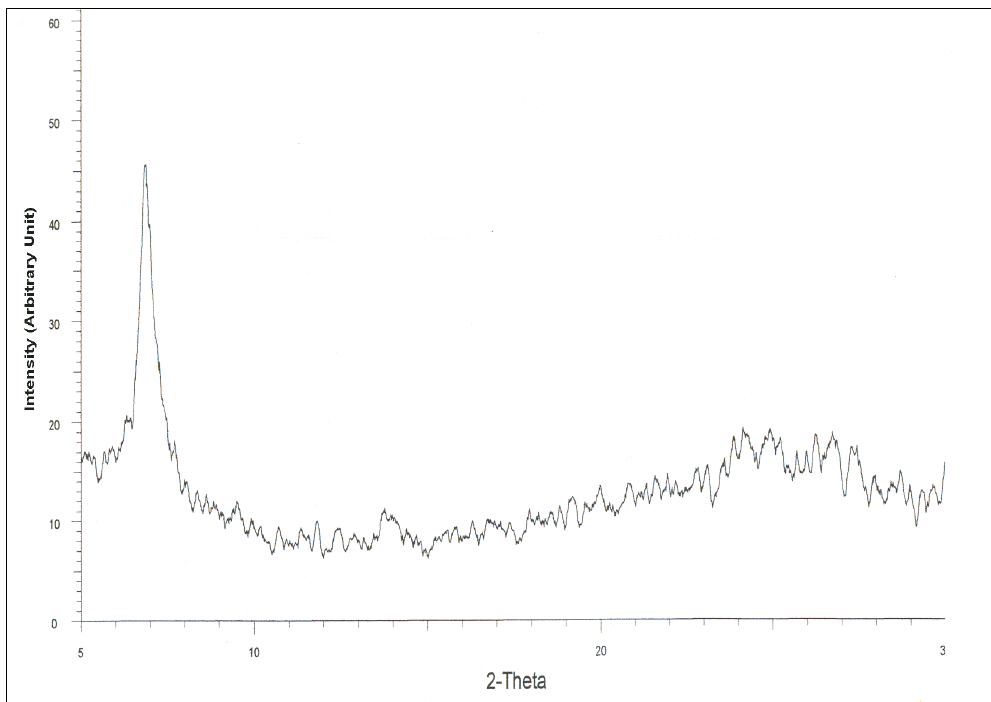
Figure 3. X-ray diffractogram of NiPc thin film prepared at substrate